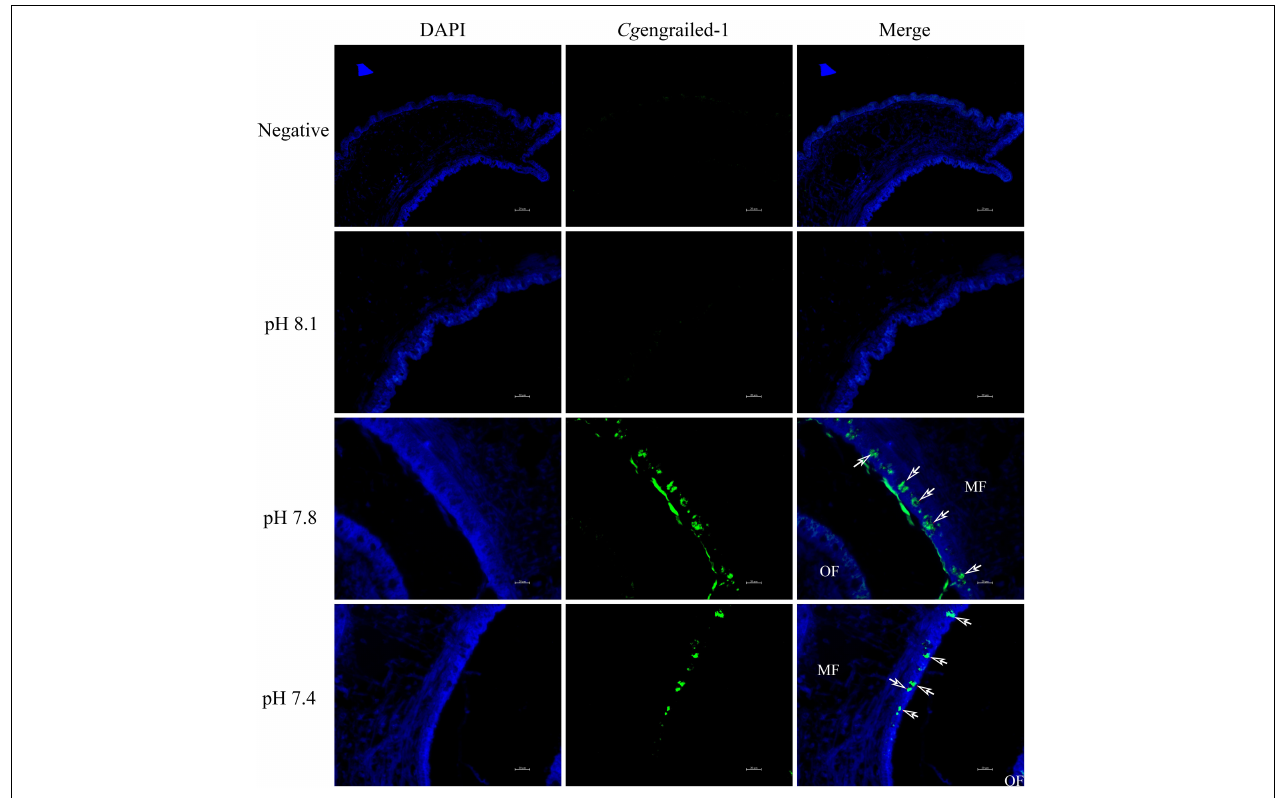
FIGURE 6 | Detection of Cg engrailed-1 in oyster mantle of upon acidification treatment by immunofluorescence assay. Nucleus was stained with DAPI and shown in blue; anti- Cg engrailed-1 coupled to Alexa fluor-488 was shown in green. The white arrow indicated the positive signal. MF, middle fold of mantle edge; OF, outer fold of mantle